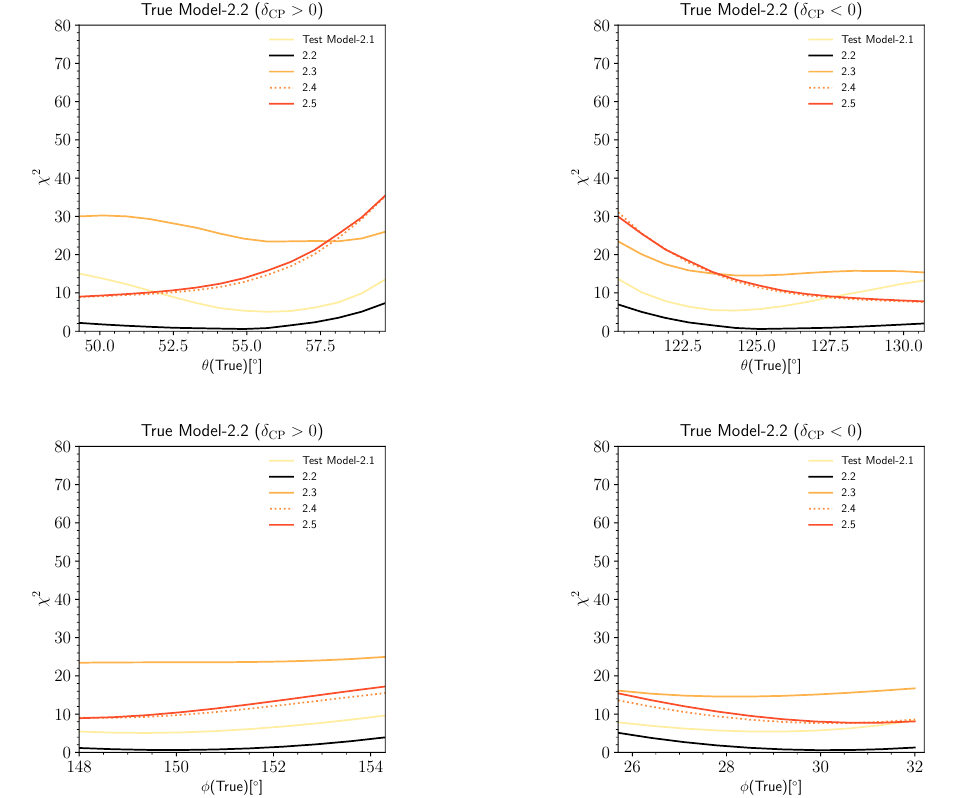
Figure 5 . Comparison among the (cid:12)ve allowed two-parameter models as test models for ESSnuSB using priors in the cases the model parameters (cid:30) (upper row) and (cid:18) (lower row) are minimized and corresponding to the (cid:12)rst (left column) and the second (right column) best-(cid:12)t points in table 8 for Model 2.2 as the true model. For description of each panel, see (cid:12)gure 3. consistent with the current data at 5 (cid:27) . From the di(cid:11)erent panels, we also note that for Models 1.3{1.5, for some of the true values of sin 2 (cid:18) 23 (true) the models could also be